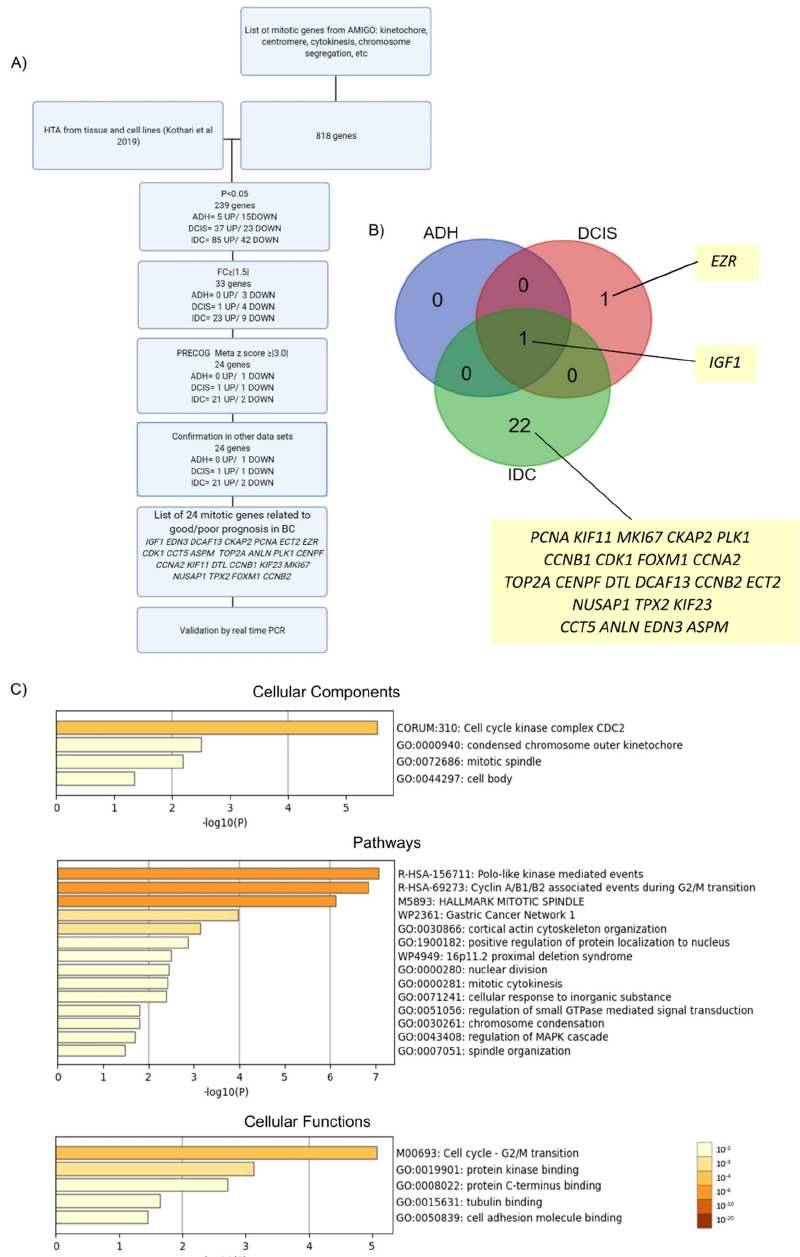
Figure 1. Enrichment analysis of mitotically relevant genes. ( A ) Flowchart of study design. HTA: human transcriptome array. p: p value. FC: fold change. PRECOG: Prediction of Clinical Outcomes from Genomic Profiles. ( B ) Venn diagram showing the 24 differentially expressed genes in each subgroup of BC progression compared to normal breast lesions. ( C ) Enrichment analysis of differentially expressed genes (DEGs) in BC using Metascape. Bar graph of enriched terms across input gene list, colored by p